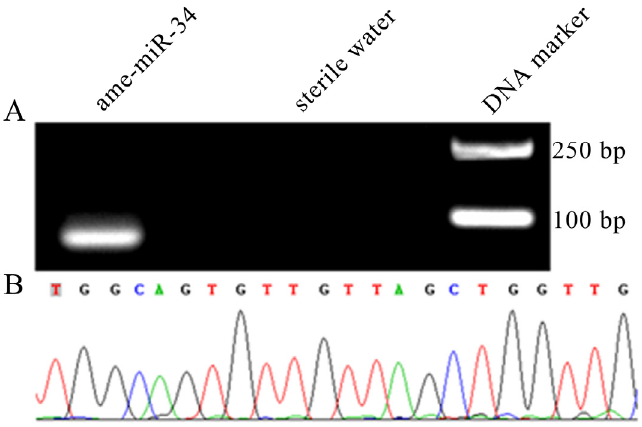
Figure 1. Validation of expression and sequence of ame-miR-34 in the A. mellifera larval gut. ( A ) Agarose gel electrophoresis for the amplification product from stem-loop RT-PCR of ame-miR-34; ( B ) Sanger sequencing of the amplified fragment from ame-miR-34.